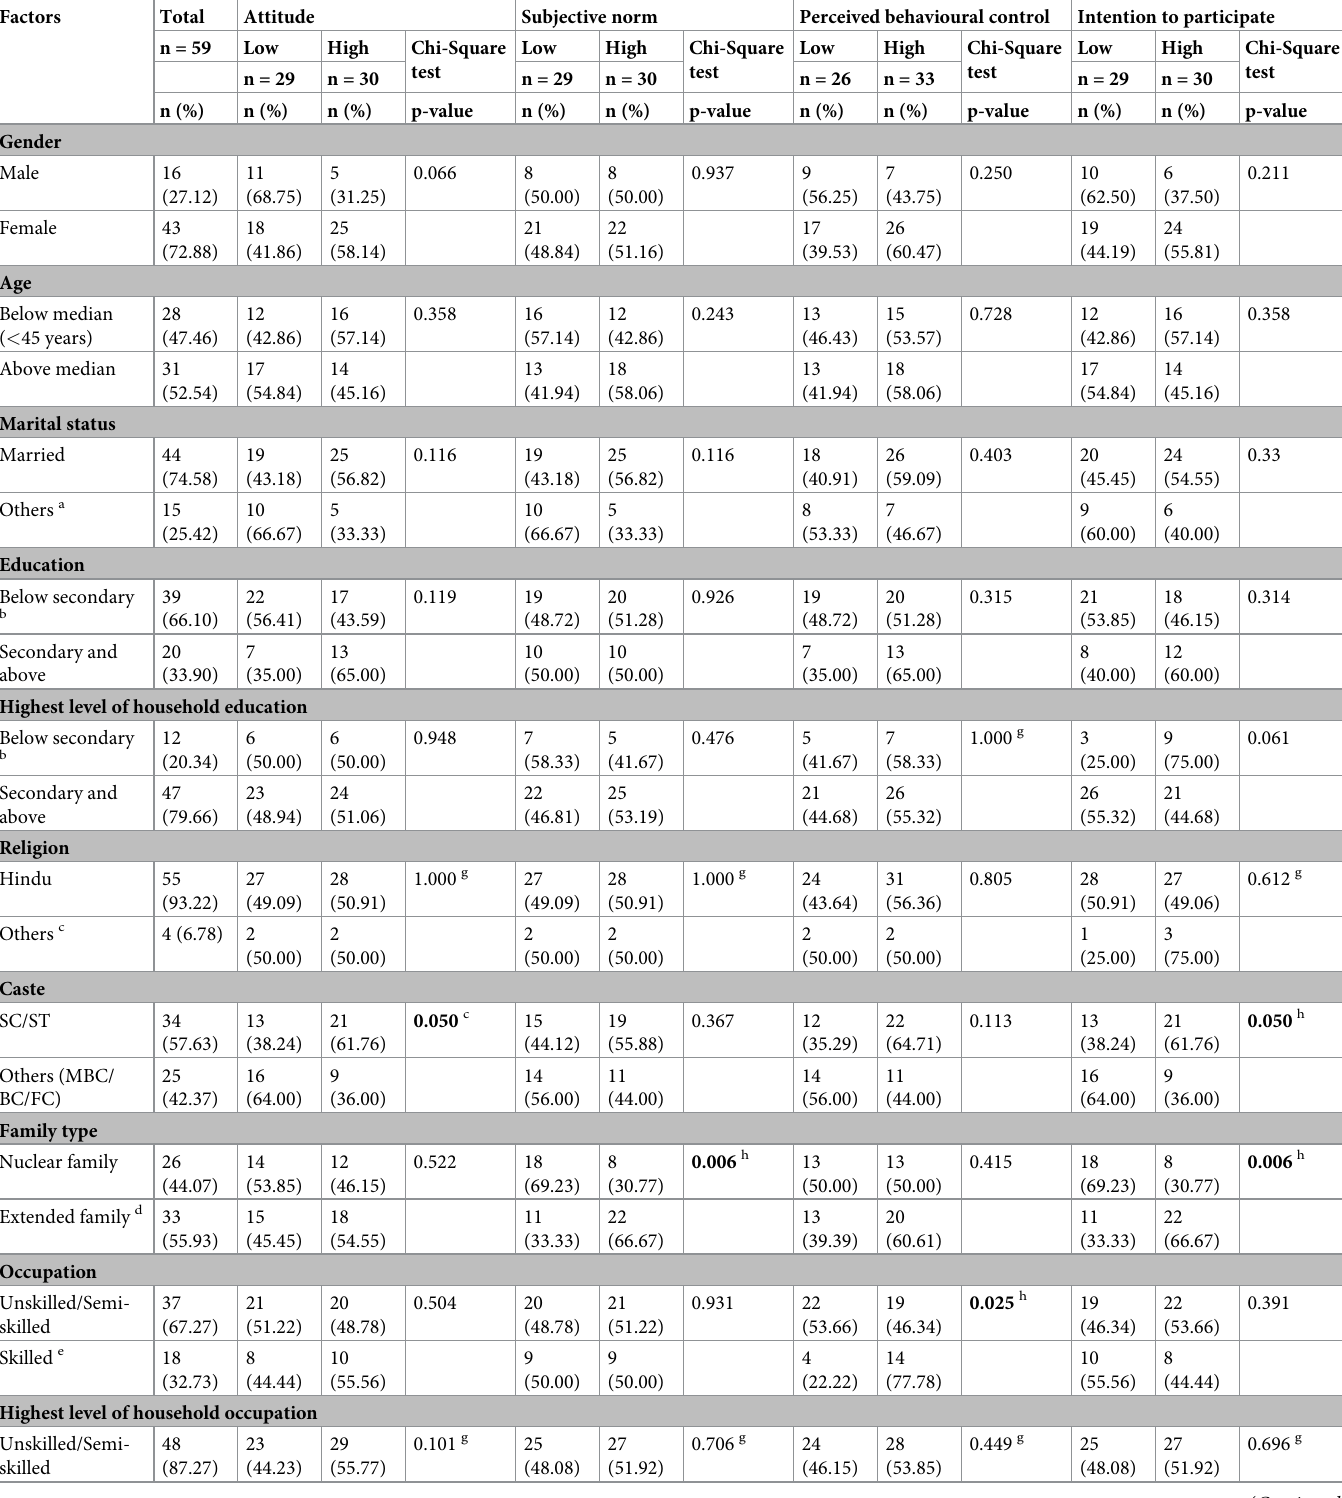
Table 1. Factors associated with attitude, subjective norm, perceived behavioural control, and intention to participate in future STH